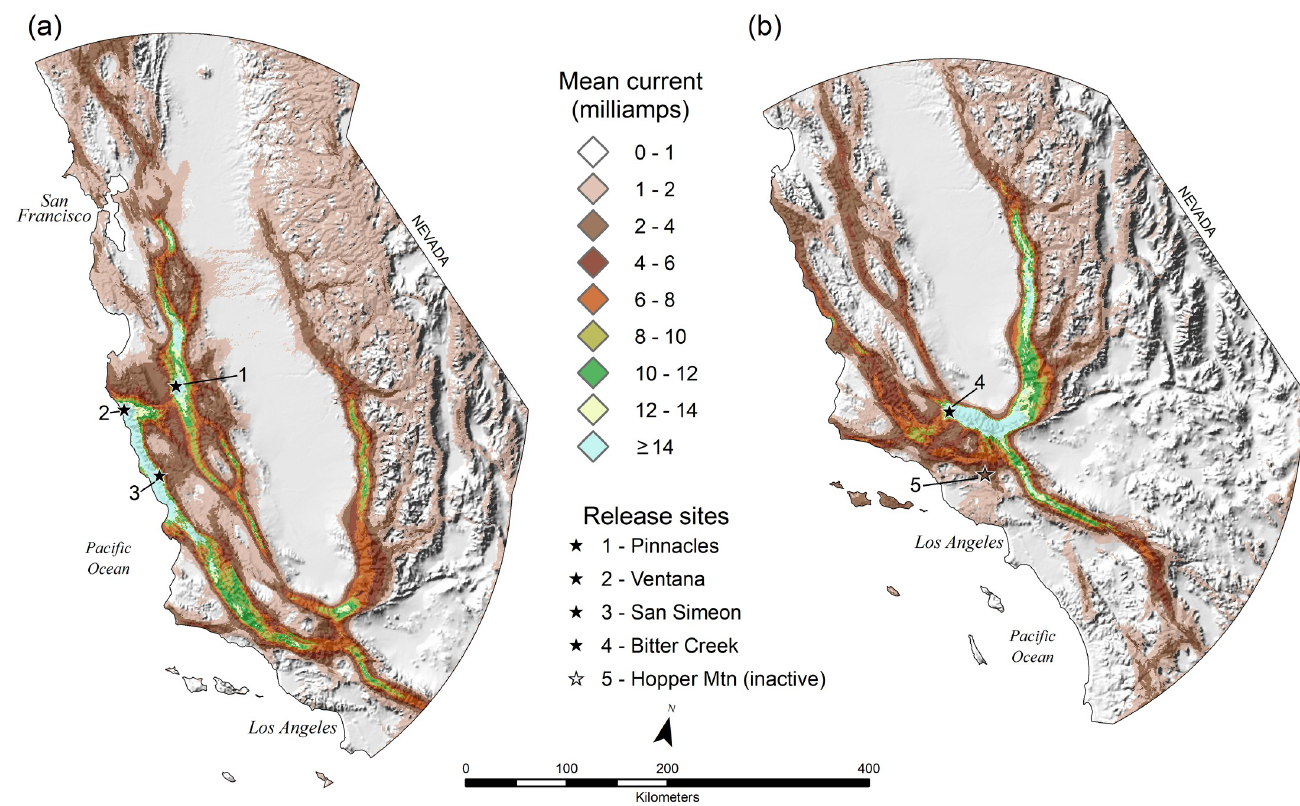
Fig 2. Mean electrical current for California condor circuit theory models in (a) central California and (b) southern California, USA.